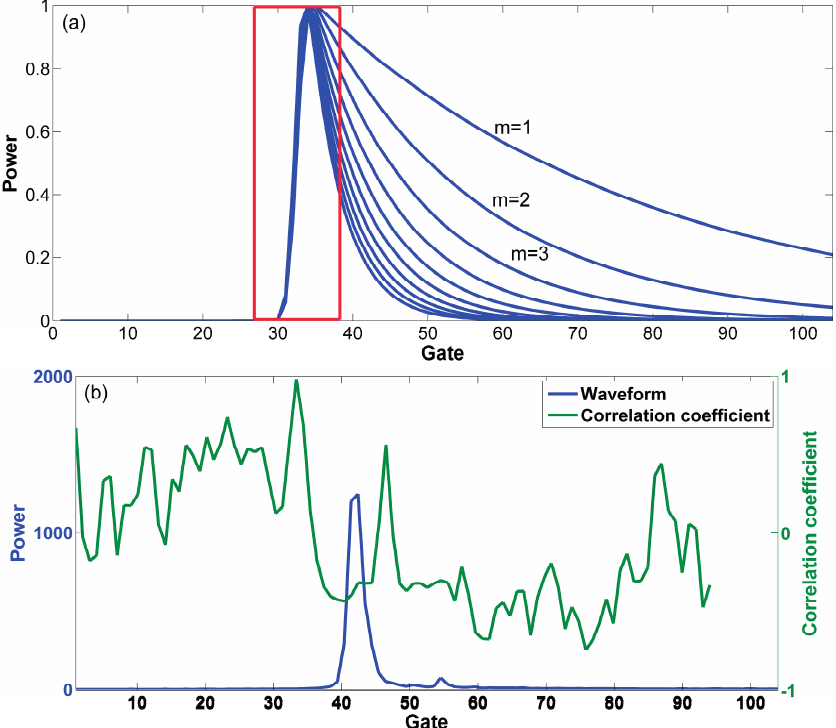
Figure 3. ( a ) Reference waveforms derived from different m values. The red box contains the reference subwaveforms of the leading edges; ( b ) Correlation coefficients of the J-2 waveform and the reference subwaveform derived by Equation (4) with m = 80 (Blue curve is J-2 waveform, and green curve is correlation